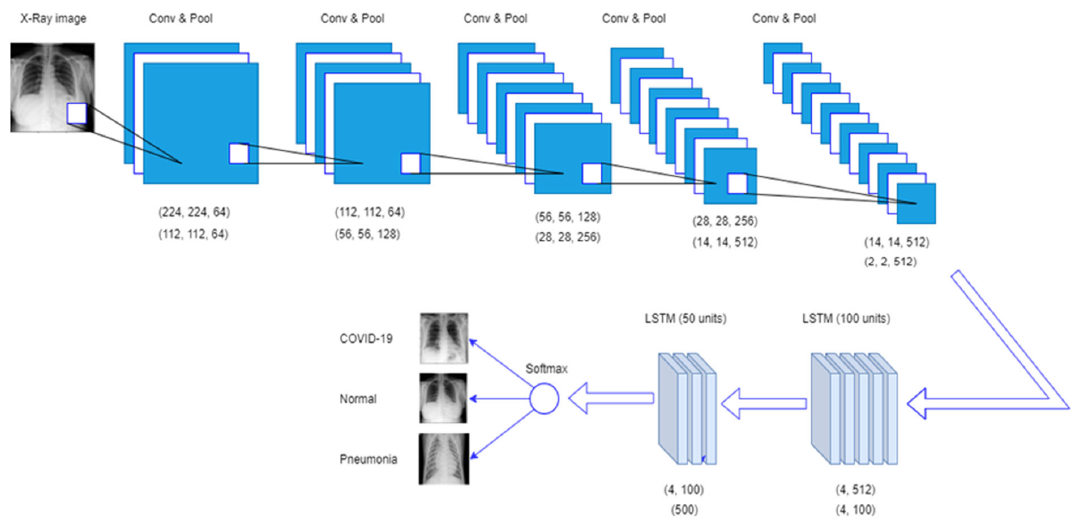
Fig. 4. An illustration of the CNN-LSTM